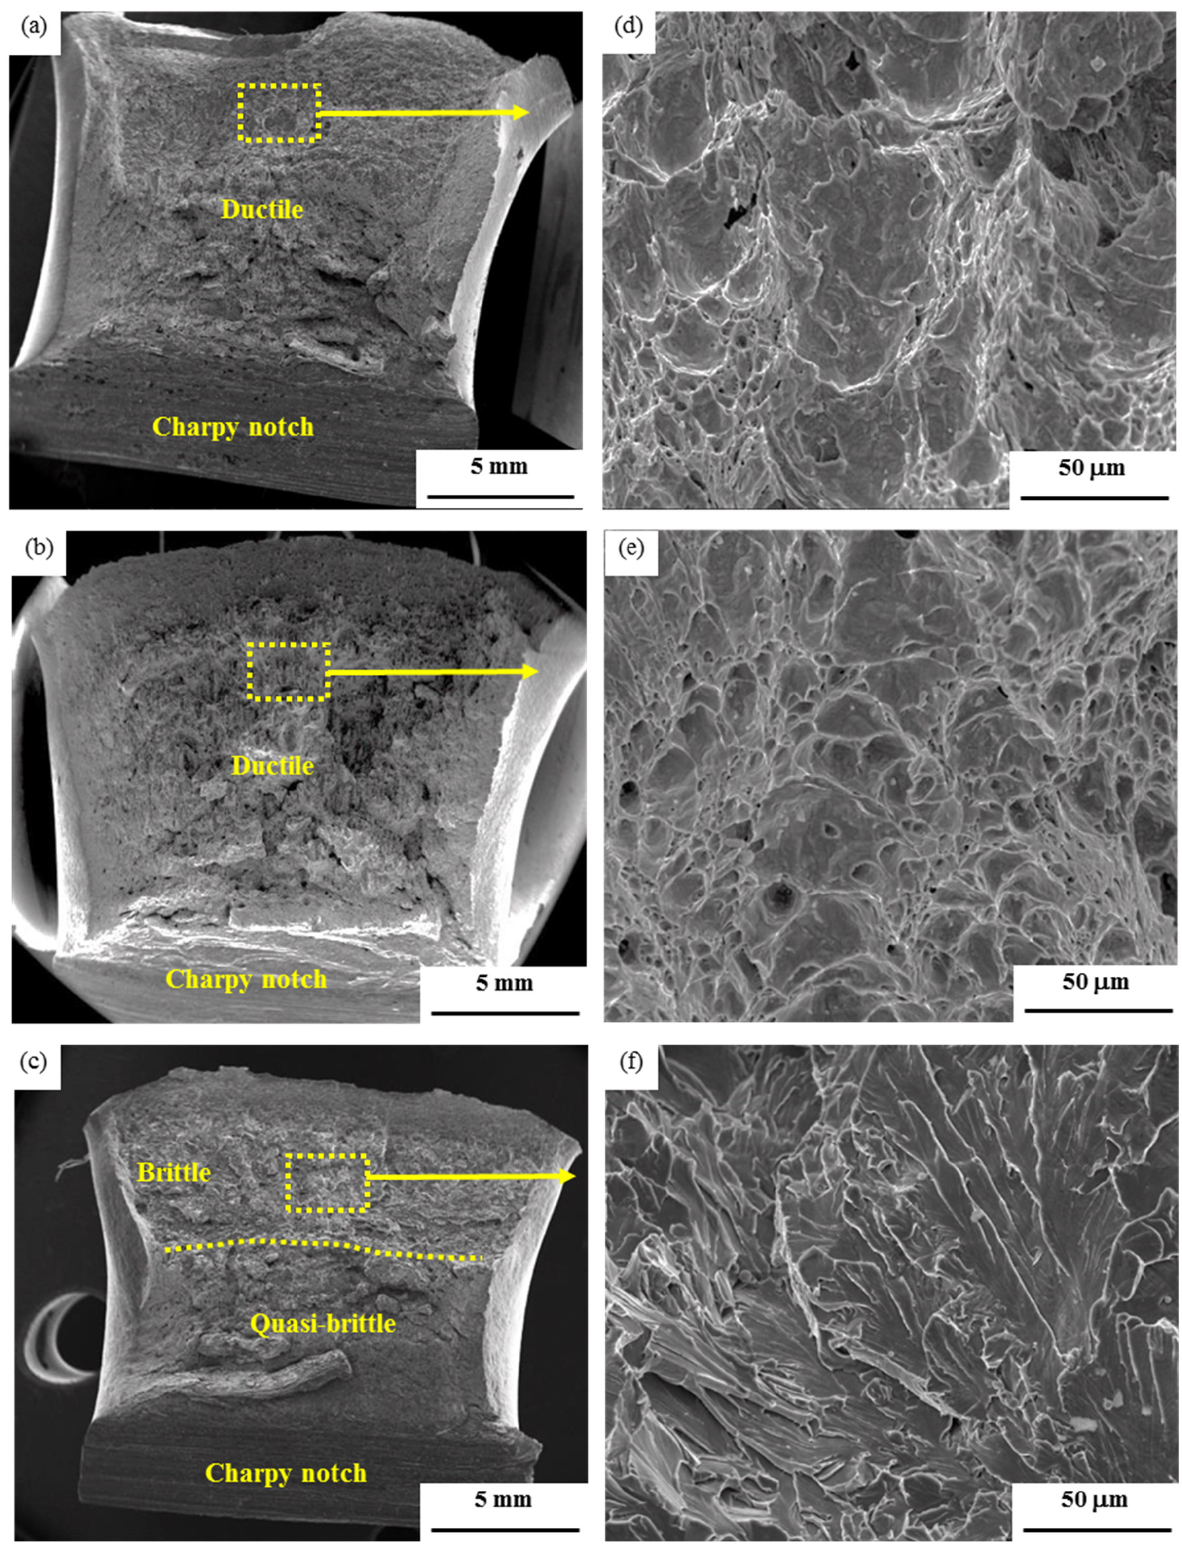
Figure 6. SEM fractographs of Charpy impact tested at − 20 °C of the base metal ( a ) and ( d ), CGHAZ with 100 kJ/cm ( b ) and ( e ), CGHAZ with 400 kJ/cm ( c ) and ( f ) of the air-cooled initial microstructure.